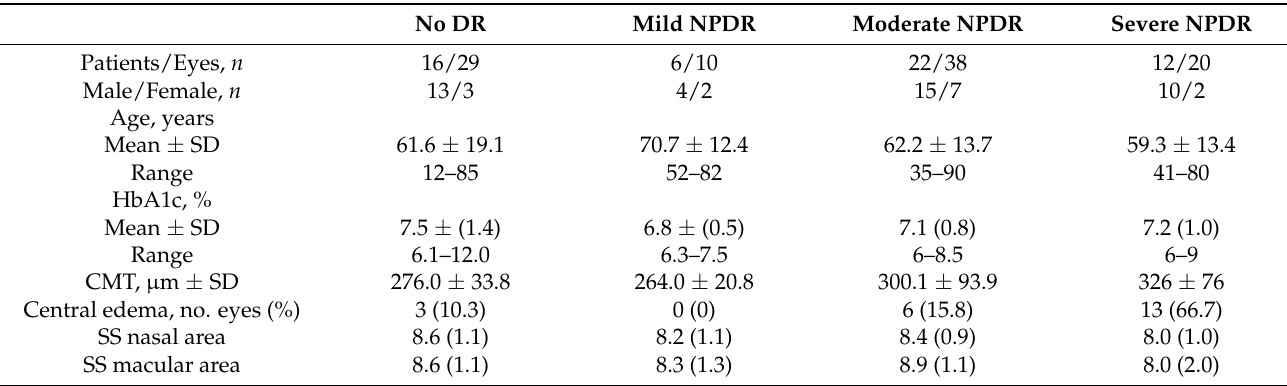
Figure 3. Flow chart of the study. Table 1. Demographics of our cohort.